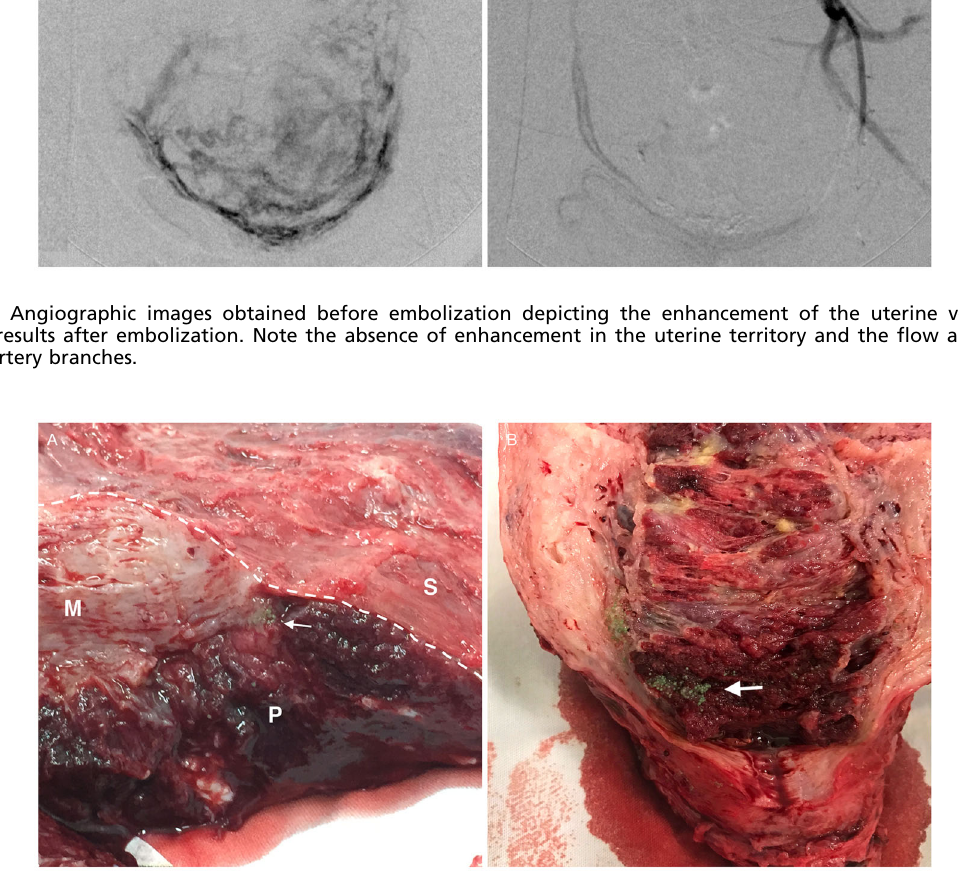
Figure 3 - (A, B) Hysterectomy specimens submitted to postoperative posterior longitudinal hysterotomy. Embolic microspheres (arrows) deep in the placental tissue (P). Note the narrowing of the myometrium (M) in the lower uterine segment where there is contact between the placenta and the uterine serosa (S), which is a typical characteristic of placenta percreta